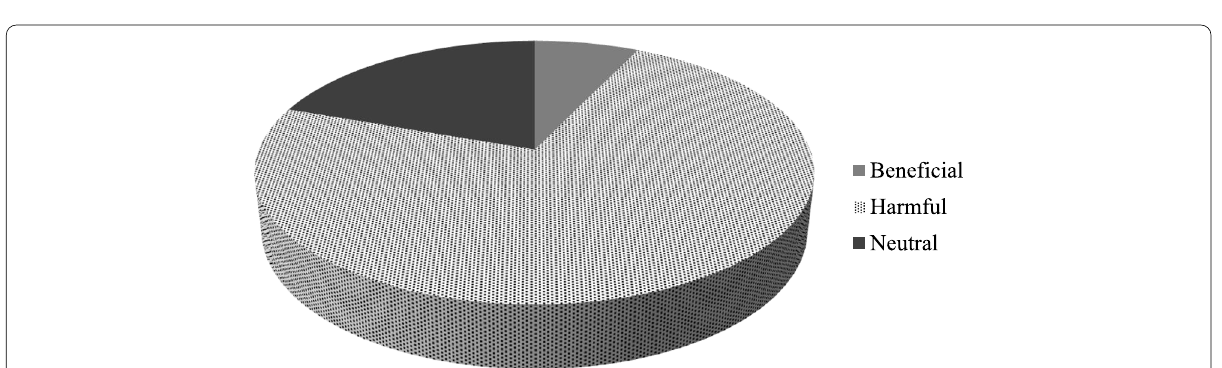
Fig. 5 Perception on benefit of snow